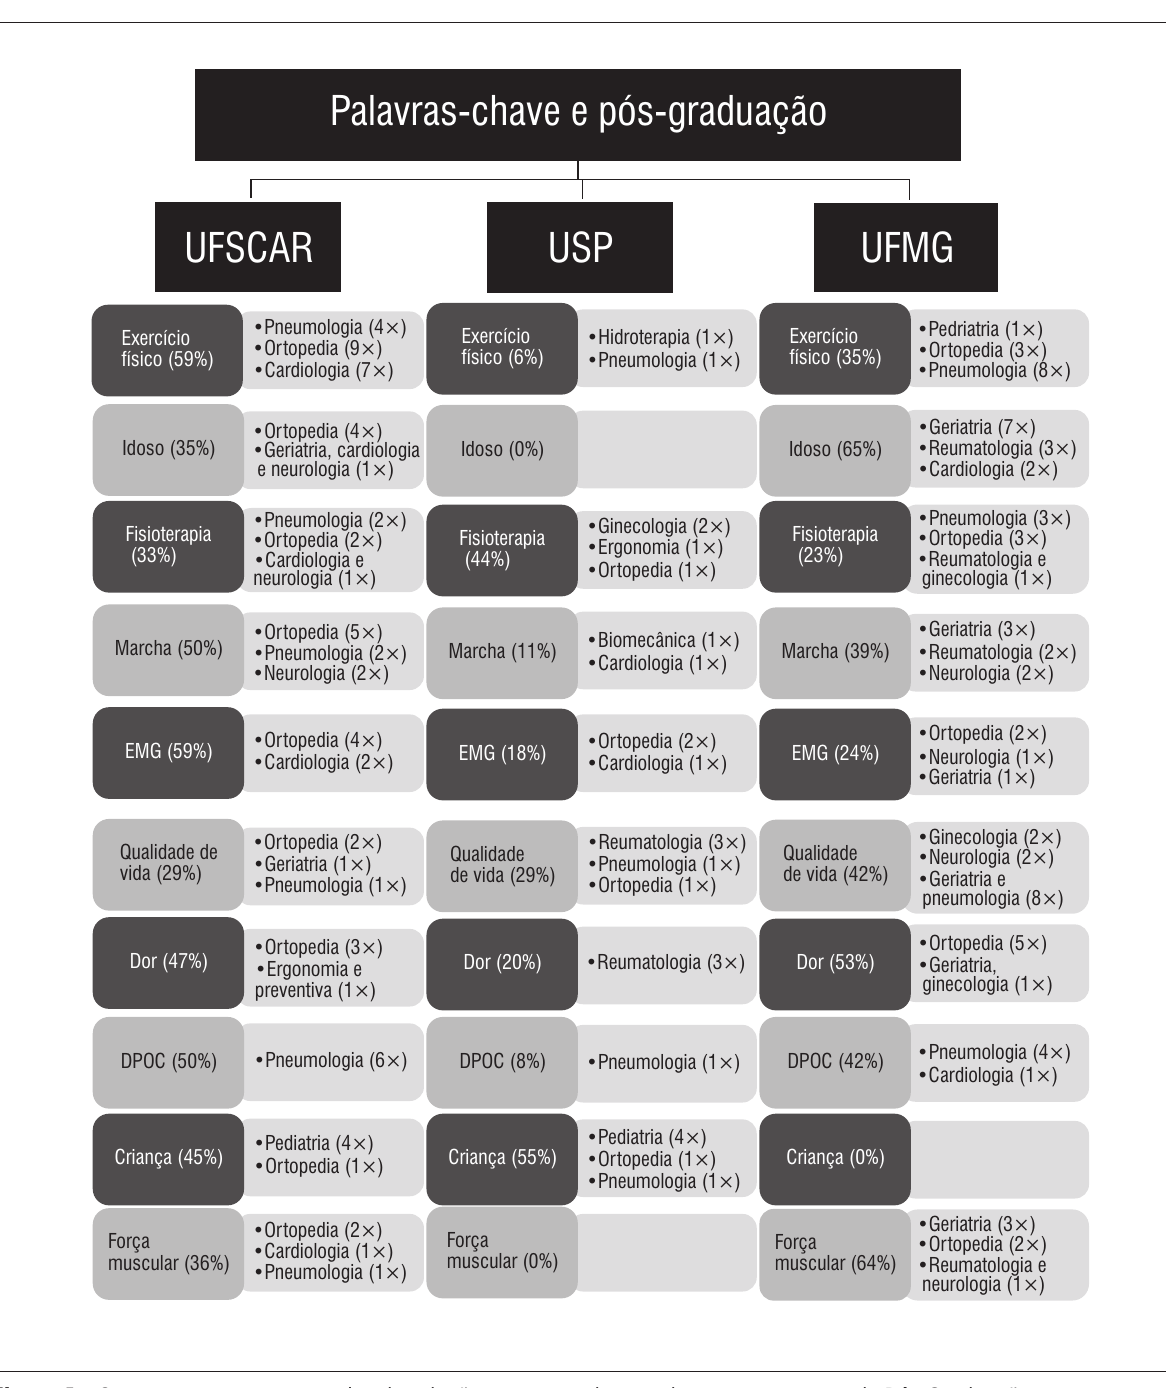
Figura 1 - Organograma representativo da relação entre as palavras-chave e o programa de Pós-Graduação. Nota: Foram listadas as dez palavras-chave mais frequentes. O percentual (%) representa a frequência da palavra em determinado programa de Pós-Graduação em relação ao total produzido pelos programas. Acompanhando a palavra-chave estão as três disciplinas mais frequentemente relacionadas e o número de vezes (X) que essa relação ocorreu. Fonte: Dados da